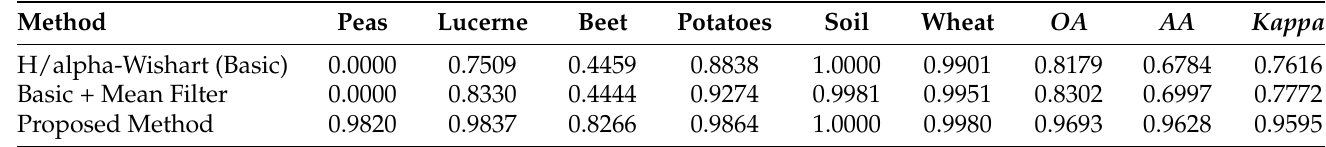
Table 4. Comparison of classification accuracy with other methods.